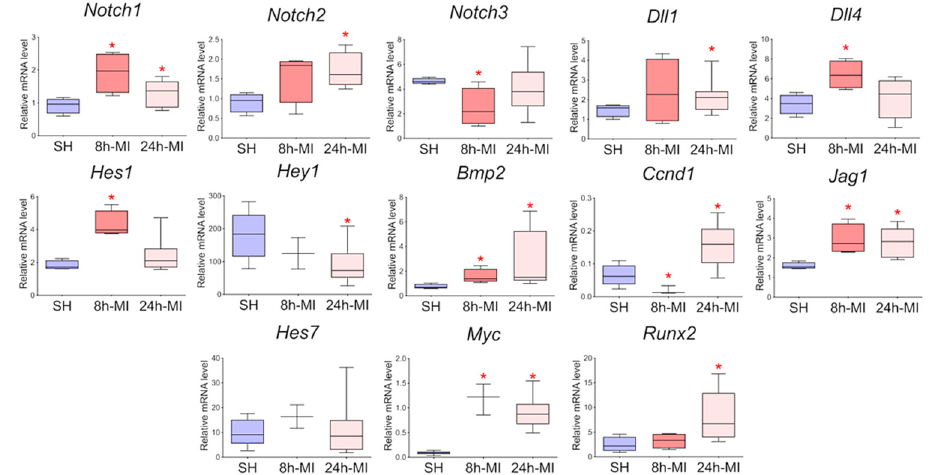
Figure 2. The dynamics of the expression of the Notch signaling pathway and Bmp2/Runx2 in tissues by quantitative PCR analysis. SH—healthy myocardium from sham-operated rats ( n = 3); 8 h-MI—tissue from the post-infarction zone of the myocardium from rats 8 h after induction ( n = 4); 24 h-MI—tissue from the post-infarction zone of the myocardium from rats 24 h after induction ( n = 9). Vertical—the relative amount of mRNA in each group, measured by the 2 −ΔΔ CT method; box plots with whiskers at min to the max are presented. * The asterisk shows significant differences between SH and MI groups at p < 0.05 (unpaired nonparametric Mann–Whitney test).